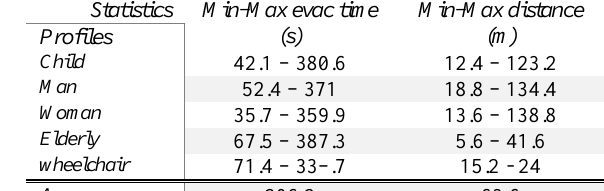
Table 5. Results of SFPE mode